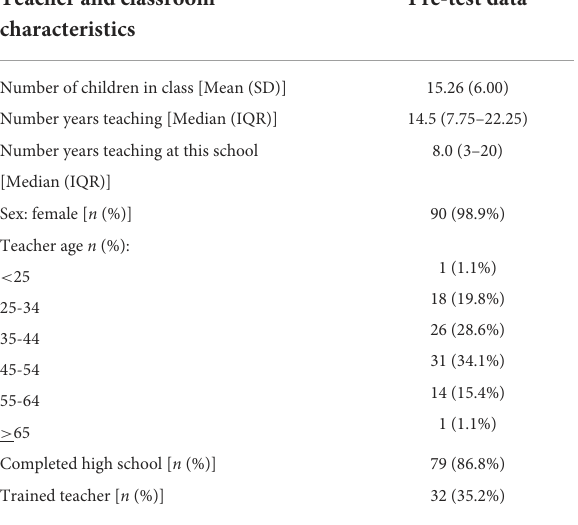
TABLE 3 Teacher and classroom characteristics at pre-test.